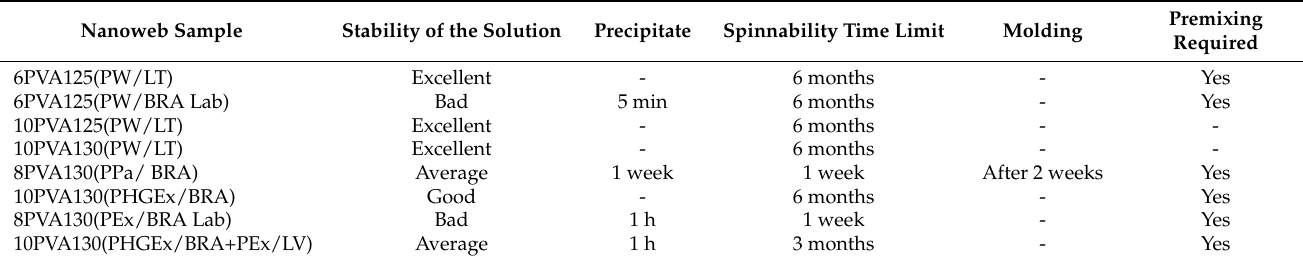
Table 6. Stability and shelf life of electrospinning solutions with propolis additive.